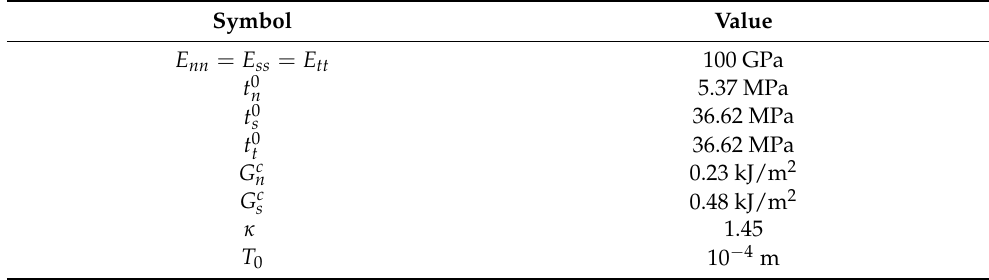
Table 4. Material properties of cohesive